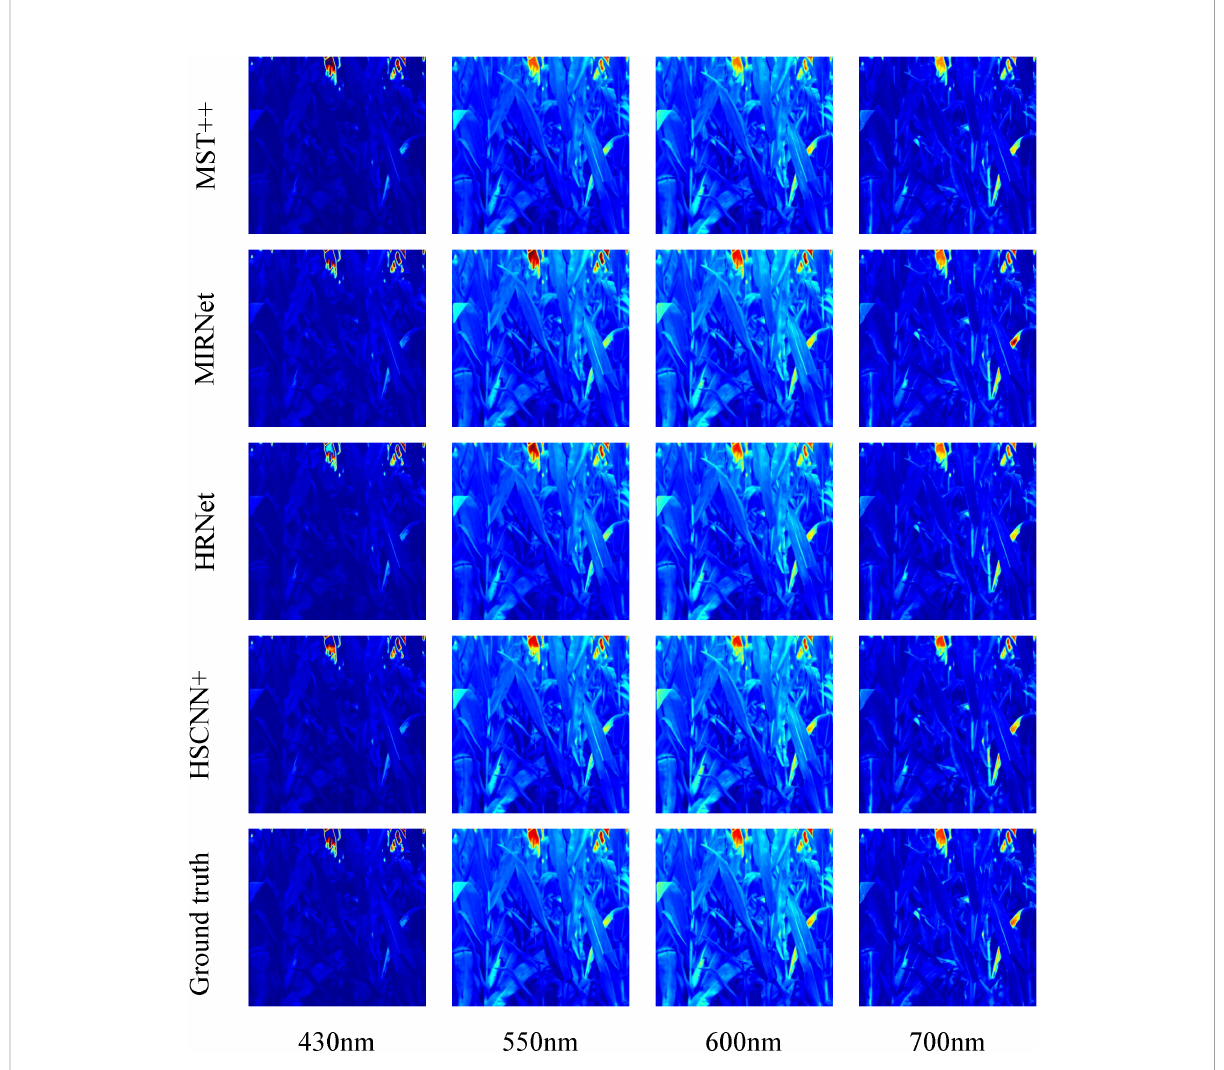
FIGURE 4 Visual comparison of four selected bands for maize spectral recovery from RGB